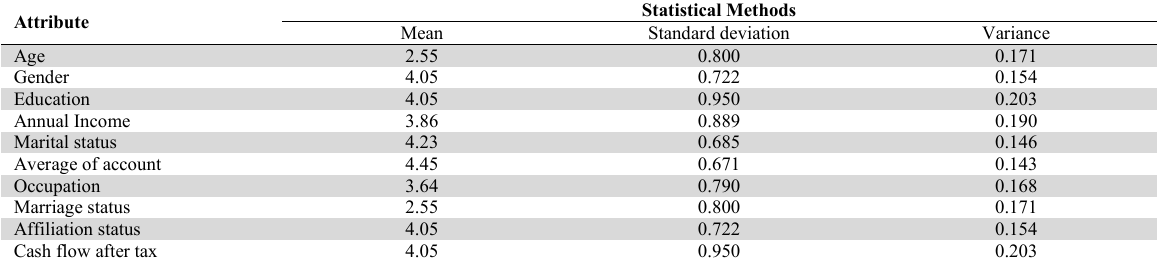
Statistical analysis of data set (bank 4) Attribute